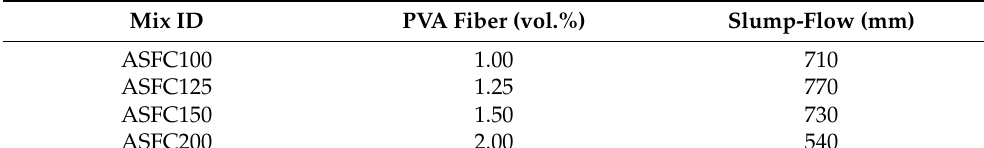
Table 4. Slump-flow test results.